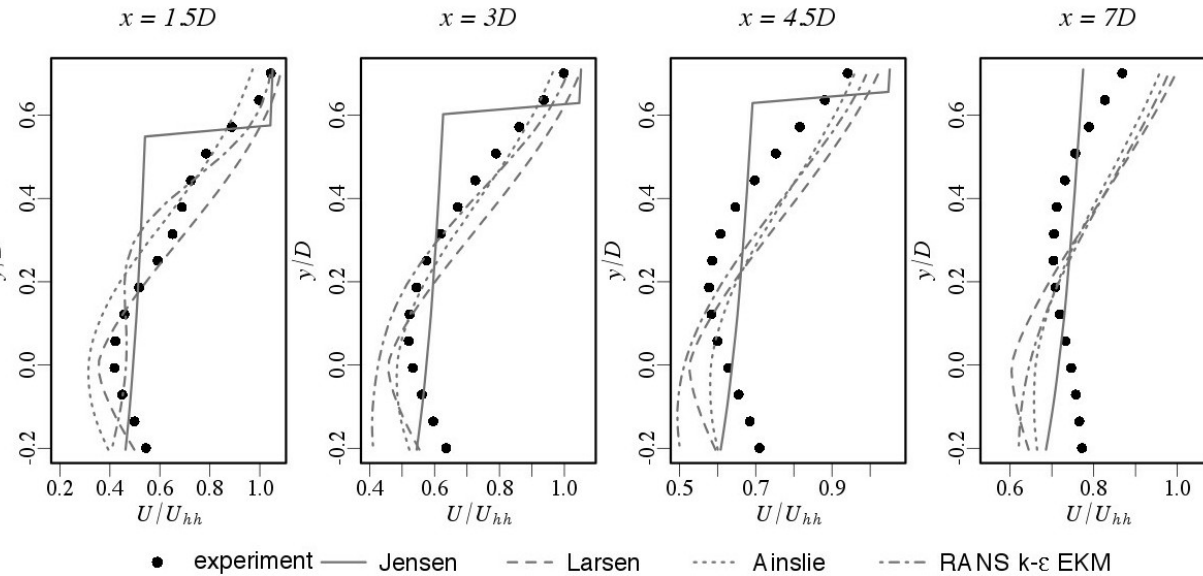
with various wake models for hh